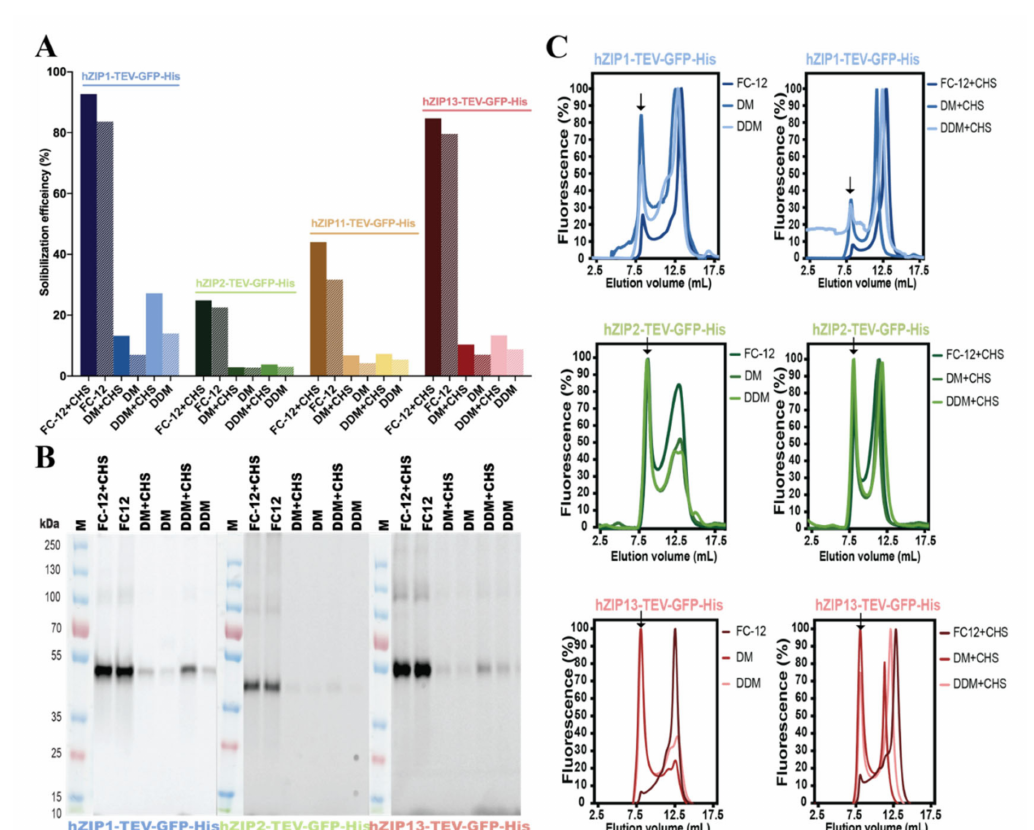
Figure 3. Detergent screening and fluorescence-detection size-exclusion chromatography (F-SEC) analysis of solubilized hZIP-TEV-GFP-His fusions. ( A ) Solubilization efficiency of crude membranes isolated from Saccharomyces cerevisiae cells (derived from 2-L cultures) expressing hZIP1-, hZIP2-, and hZIP13-TEV-GFP-His (72-h induction at 15 ◦ C) or hZIP11-TEV- GFP-His (48-h induction at 15 ◦ C). For hZIP1, 2, and 13 analyzed material was solubilized for 2 h at 4 ◦ C with FC-12 (at final concentration of 1%, w / v ), DM (1%, w / v ), and DDM (1%, w / v ) with and without CHS (0.34%, w / v ). For hZIP11, the final concentrations were doubled. Following treatment with the respective detergents, GFP fluorescence was measured in the supernatant after ultracentrifugation and percentage of solubilization efficiency was calculated. CHS: cholesteryl hemisuccinate Tris salt. ( B ) In-gel GFP fluorescence of SDS-PAGE-separated detergent-solubilized crude S. cerevisiae membranes overexpressing hZIP1, 2, and 13 C-terminally fused to TEV-GFP-His-tag. Extraction conditions are identical to ( A ) and the analyzed material represents ultracentrifuged supernatant from the respective solubilization. The predicted MWs of the respective fusions are 63.3 kDa (hZIP1), 61.8 kDa (hZIP2), 63.8 kDa (hZIP11), and 68 kDa (hZIP13). M: marker. ( C ) F-SEC analysis of detergent-solubilized crude S. cerevisiae membranes overexpressing hZIP1, 2, and 13 C-terminally fused to TEV-GFP-His-tag. Extraction conditions are identical to ( A ) and analyzed material includes ultracentrifuged supernatant from the respective solubilization. Normalized F-SEC chromatograms were obtained after separation on Superdex 200 Increase 10/300 GL column where GFP fluorescence of the eluate was monitored. Arrows indicate the estimated elution positions of the void